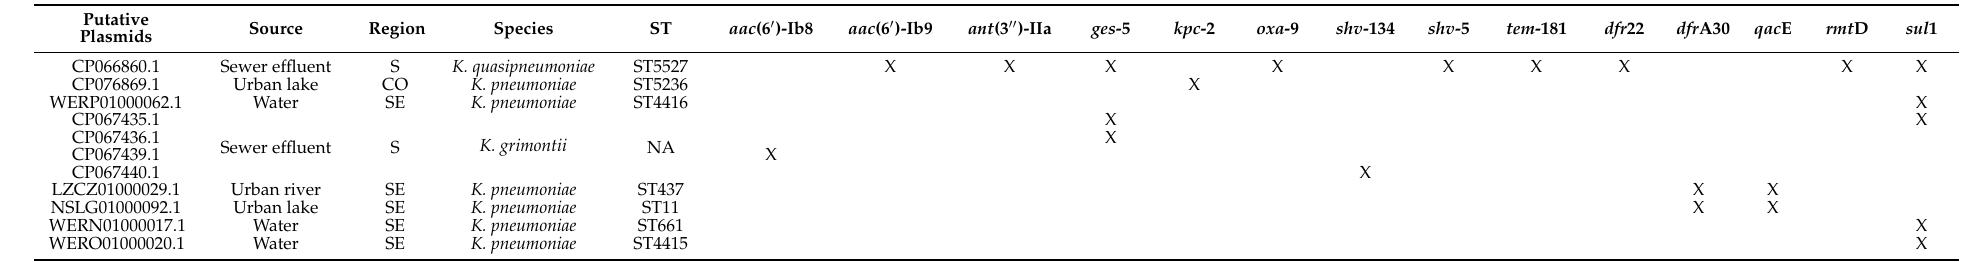
Table 6. Antibiotic resistance genes identified in putative plasmids from Klebsiella environmental genomes. Putative